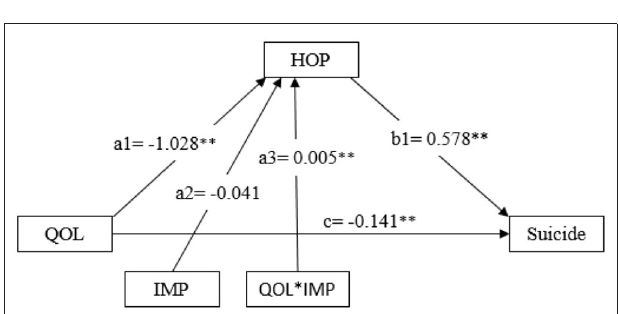
FIGURE 3 | Schematic model of impulsivity as the moderator in the relationship between quality of life and hopelessness, quality of life and suicide. QOL, quality of life; HOP, hopelessness; IMP, impulsivity. Model coefficients were estimated using the SAS Macro PROCESS (see text for detail); *: p < 0.05, **: p <